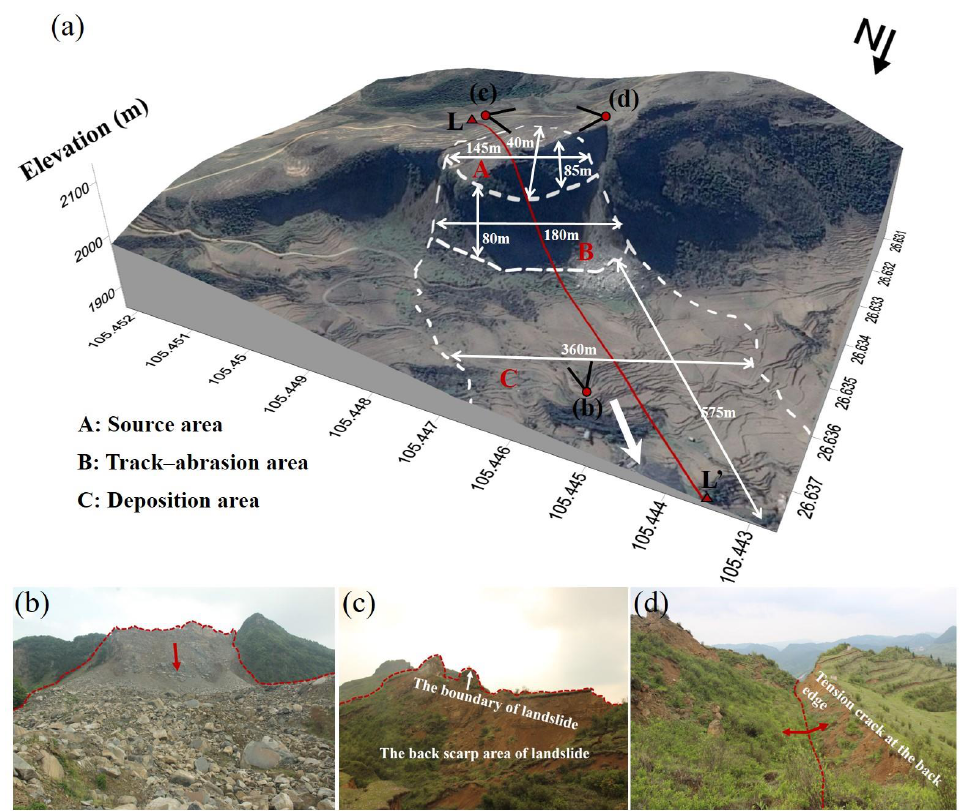
Figure 2. The bird's eye view of the Pusa landslide (revised from [1]). ( a ) The major sliding zones, including three sections, namely, A source area, B track-abrasion area, and C deposition area. ( b – d ) are three on-site photos taken at positions shown in Figure 2a.